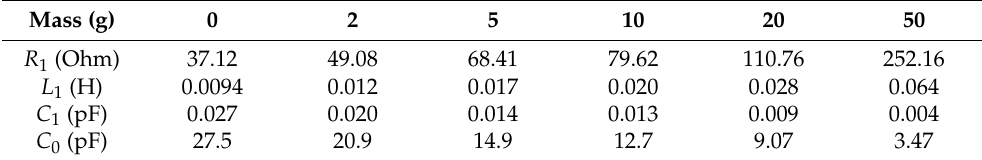
Table 2. The coefficients of an equivalent model for a BAW strain sensor.